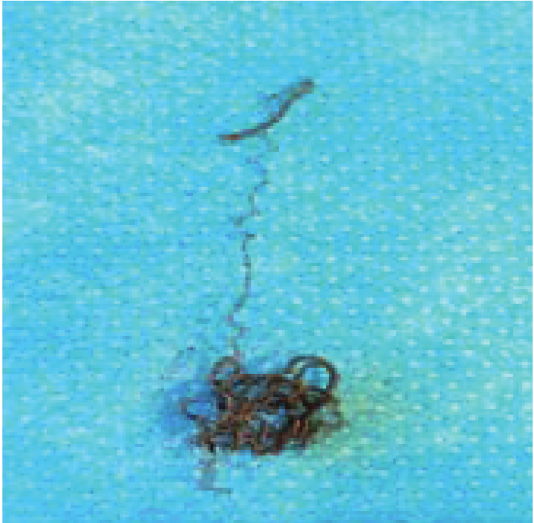
Figure 4: Additional endoscopically removed excess coil material from the exit area in a surgical